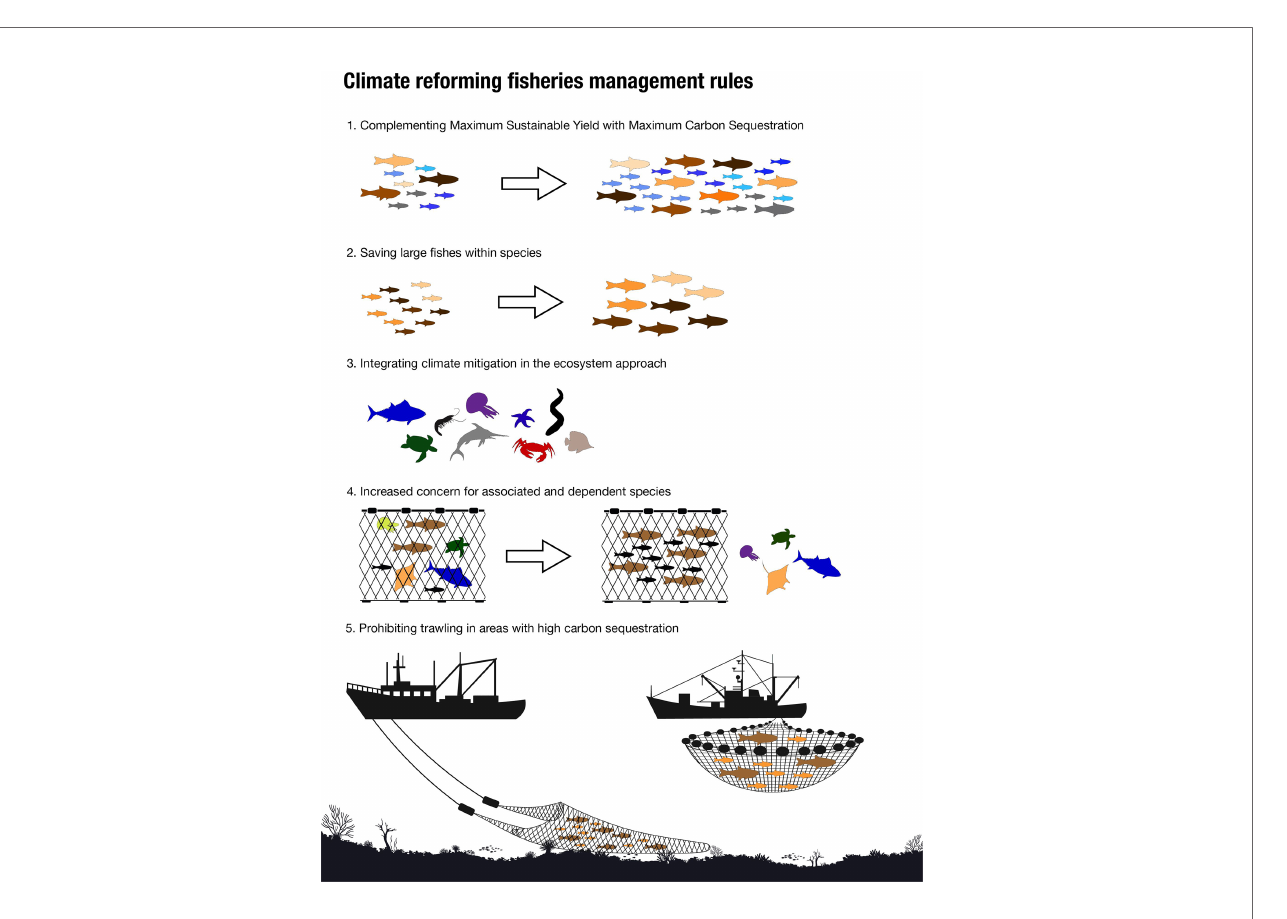
FIGURE 1 | Climate Reforming Fisheries Management